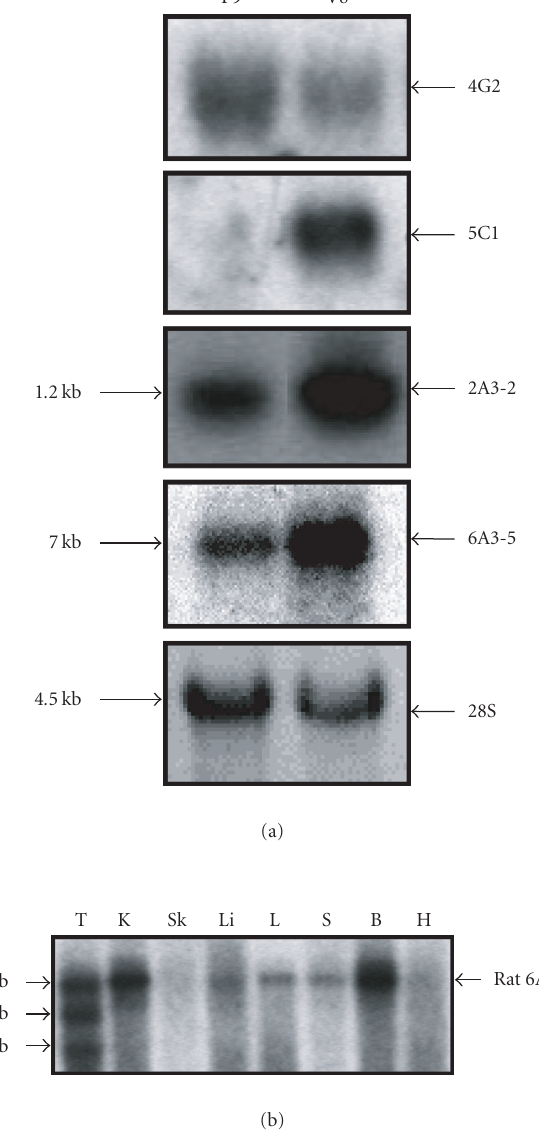
Figure 2. Northern blot analysis of 6A3-5 di ff erentially displayed cDNA band. (a) Four genes (4G2, 5C1, 2A3-2, 6A3-5), showing no similarities in the databases, were confirmed by northern blots to be di ff erentially expressed. The 6A3-5 gene is upregulated in proliferating (V8) but not synthetic cells (P9). Quantification of 6A3-5 signals ( n = 3), reported to 28S levels, showed a 3-fold increase in the V8 compared to the P9 cells. The 6A3-5 mRNA has a size of 7kb as given by northern blot. The internal deposition control of the same RNA quantity is given by 28S. Lanes P9 and V8 correspond respectively to synthetic and rapidly proliferating cells. (b) Multiple-tissue northern blot analysis with the 6A3-5 cDNA band in the rat. The blot contained 20 µ g of total RNA from various rat tissues and was probed with the 6A3-5 cDNA fragment isolated by DD. Transcripts of ∼ 7kb could be observed in all rat tissues analyzed, but at di ff erent levels of expression. Indeed, brain, kidney, and testis tissues expressed this gene at very high levels. Two lower transcripts of ∼ 6 and ∼ 5kb were also observed for testis. Lane T, testis; lane K, kidney; lane Sk, skeletal muscle; lane Li, liver; lane L, lung; lane S, spleen; lane B, brain; lane H,